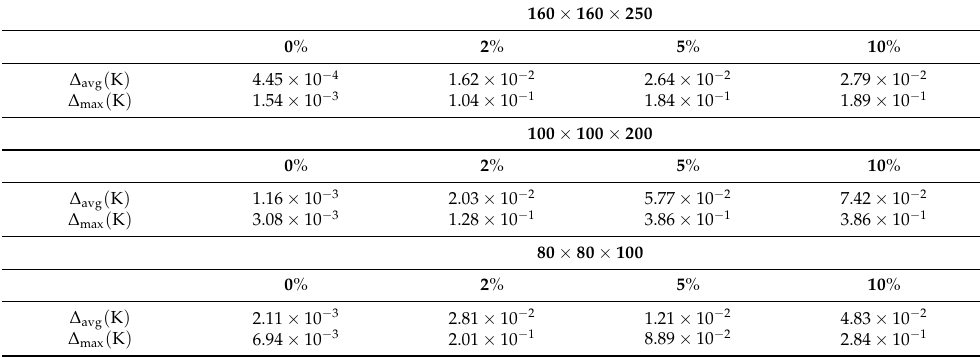
Table 5. Errors of reconstruction function u in measurement points for twelve measurement points ( ∆ avg —average absolute error, ∆ max —maximum absolute error, δ avg —average relative error, δ max — maximum relative